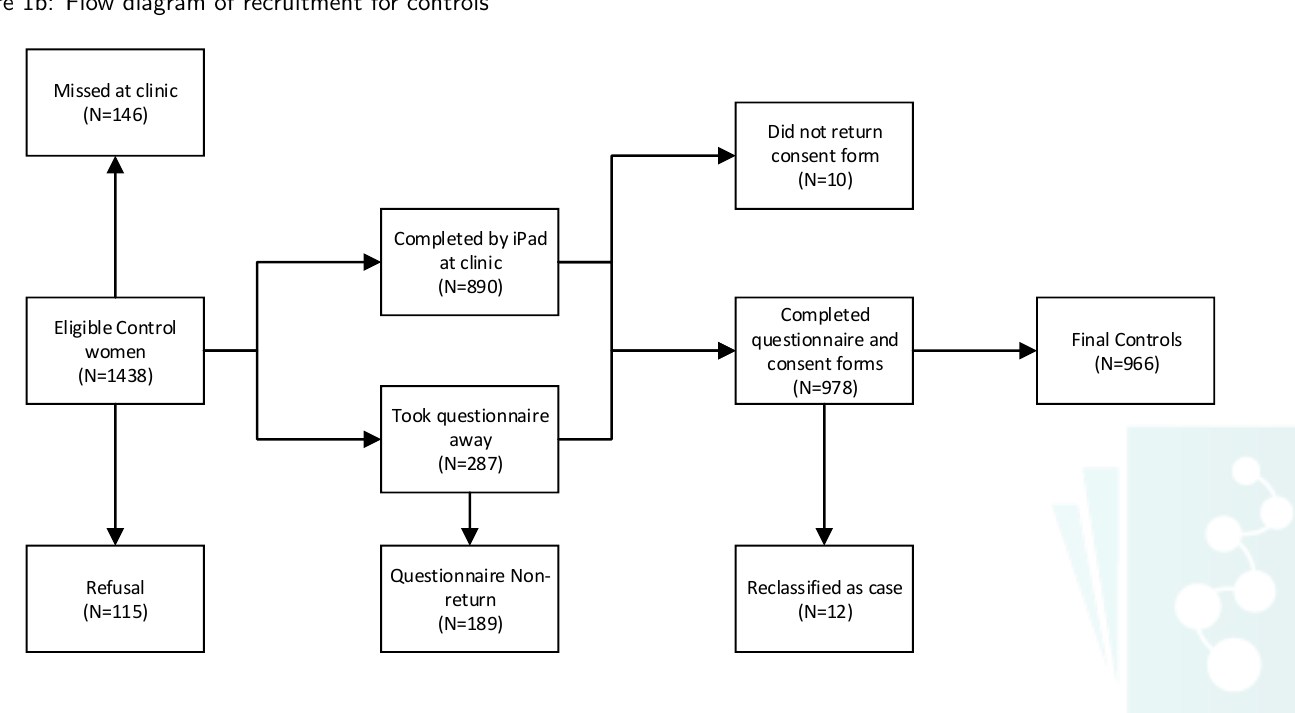
Figure 1b: Flow diagram of recruitment for